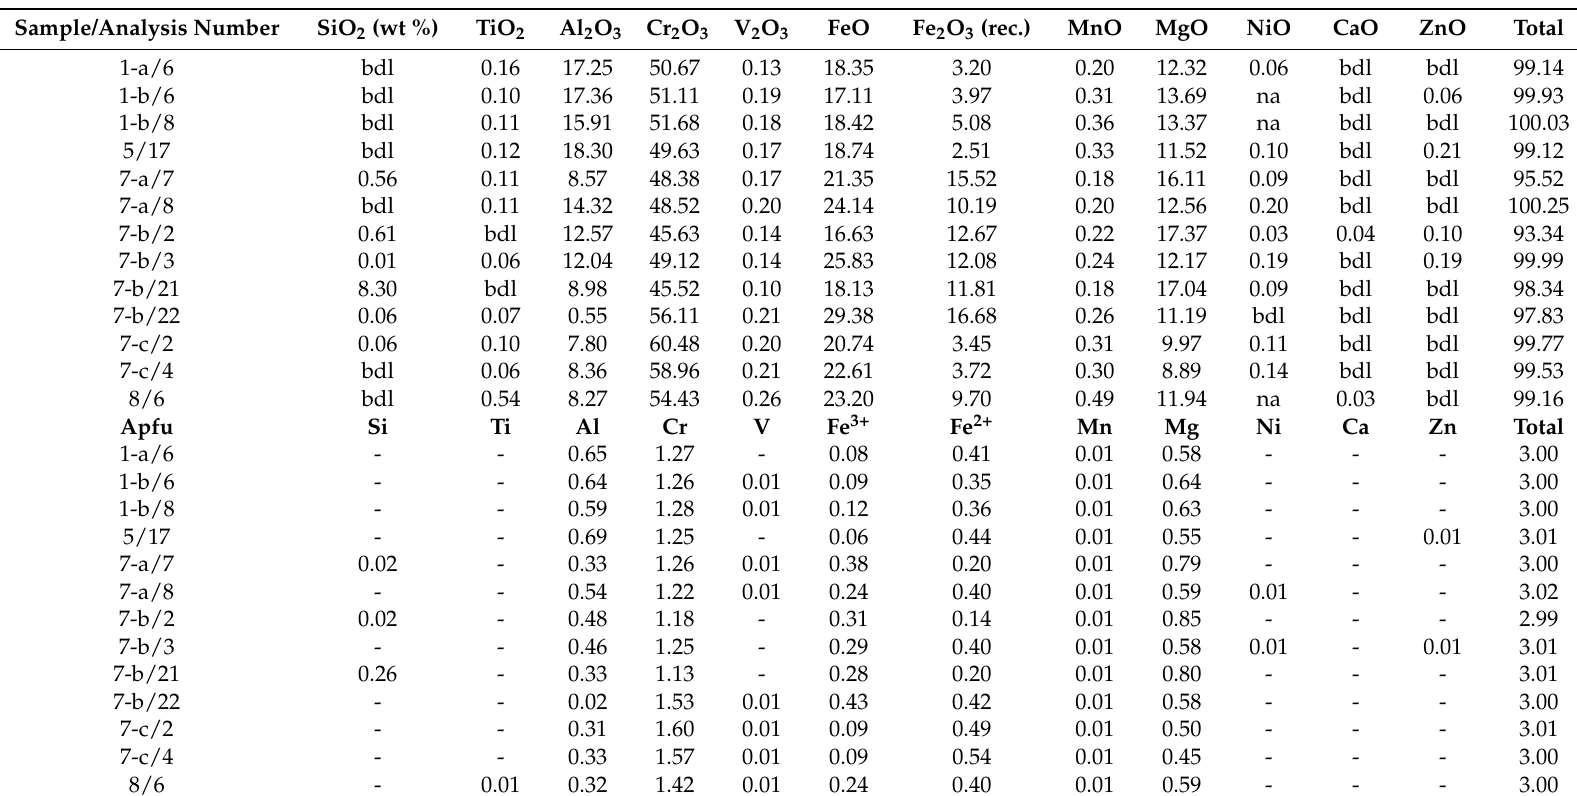
Table A3. Electron-microprobe analyses and structural formulae (on the basis of 4 atoms of O) of porous spinel and lamellae-rich spinel. All analyses correspond to porous spinel except for analyses 7-a/7, 7-b/2 and 7-b/21, which represent lamellae-rich spinel. Analyses from samples 7-a and 7-b represent pair analyses. Fe 2 O 3(rec.) is not included in the Total of each analysis. Abbreviations: bdl = below detection limit; na = not